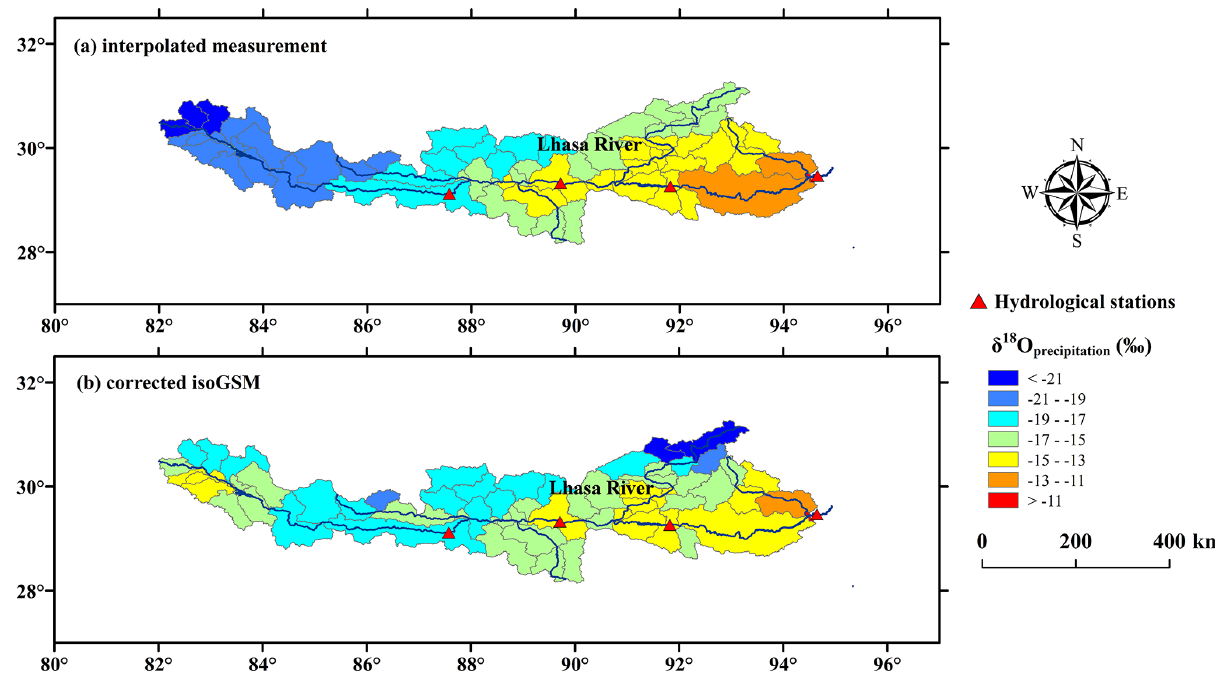
Figure 5. Spatial distribution of average precipitation isotope composition obtained by (a) interpolated measurement data and (b) corrected